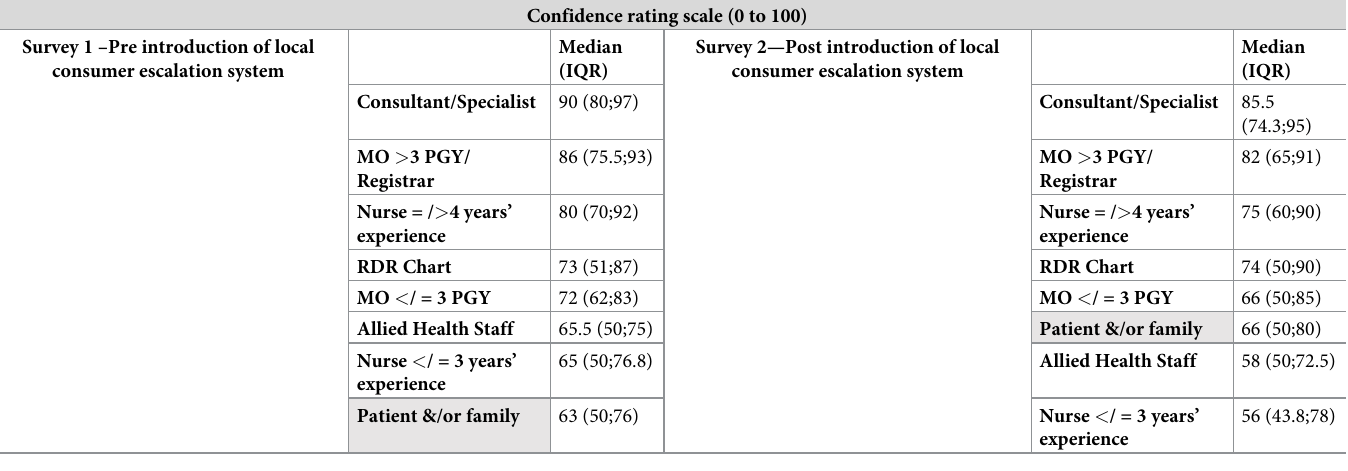
Table 2. Staff confidence in the ability and reliability of clinicians, the RDR chart, and patients/family members to identify acute clinical deterioration.